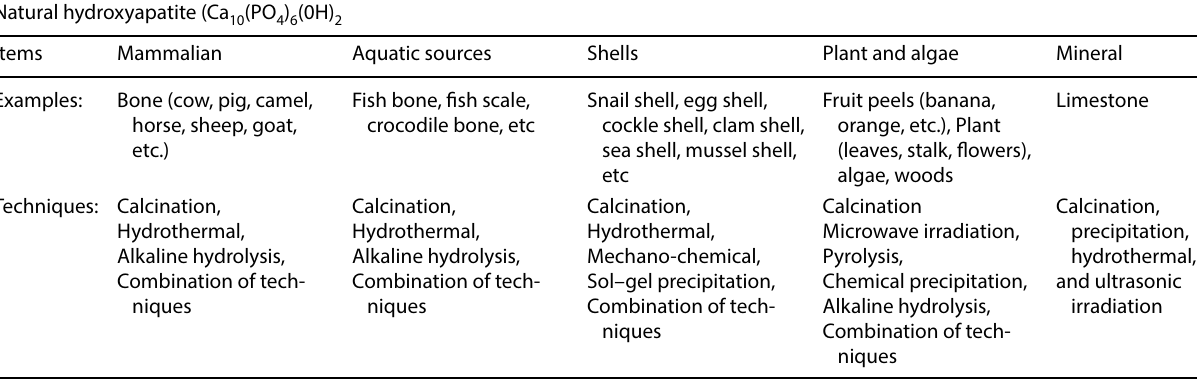
Table 1 The sources and some techniques used for synthesizing natural HAp [69] Natural hydroxyapatite (Ca